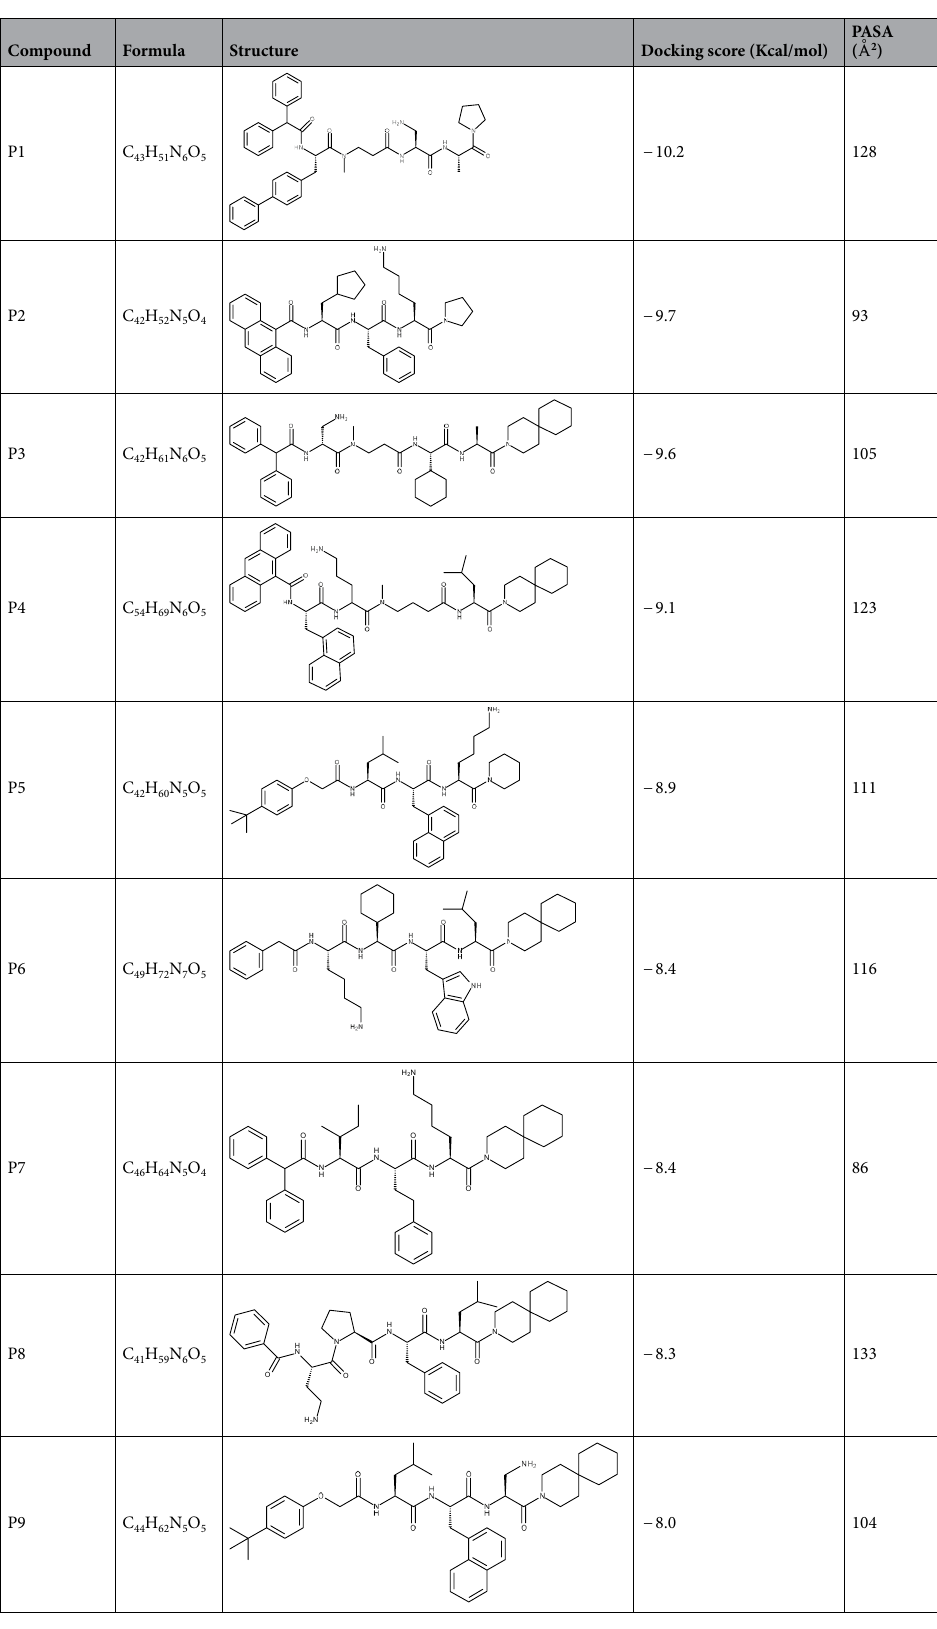
Table 2. First set of inhibitors, docking scores and